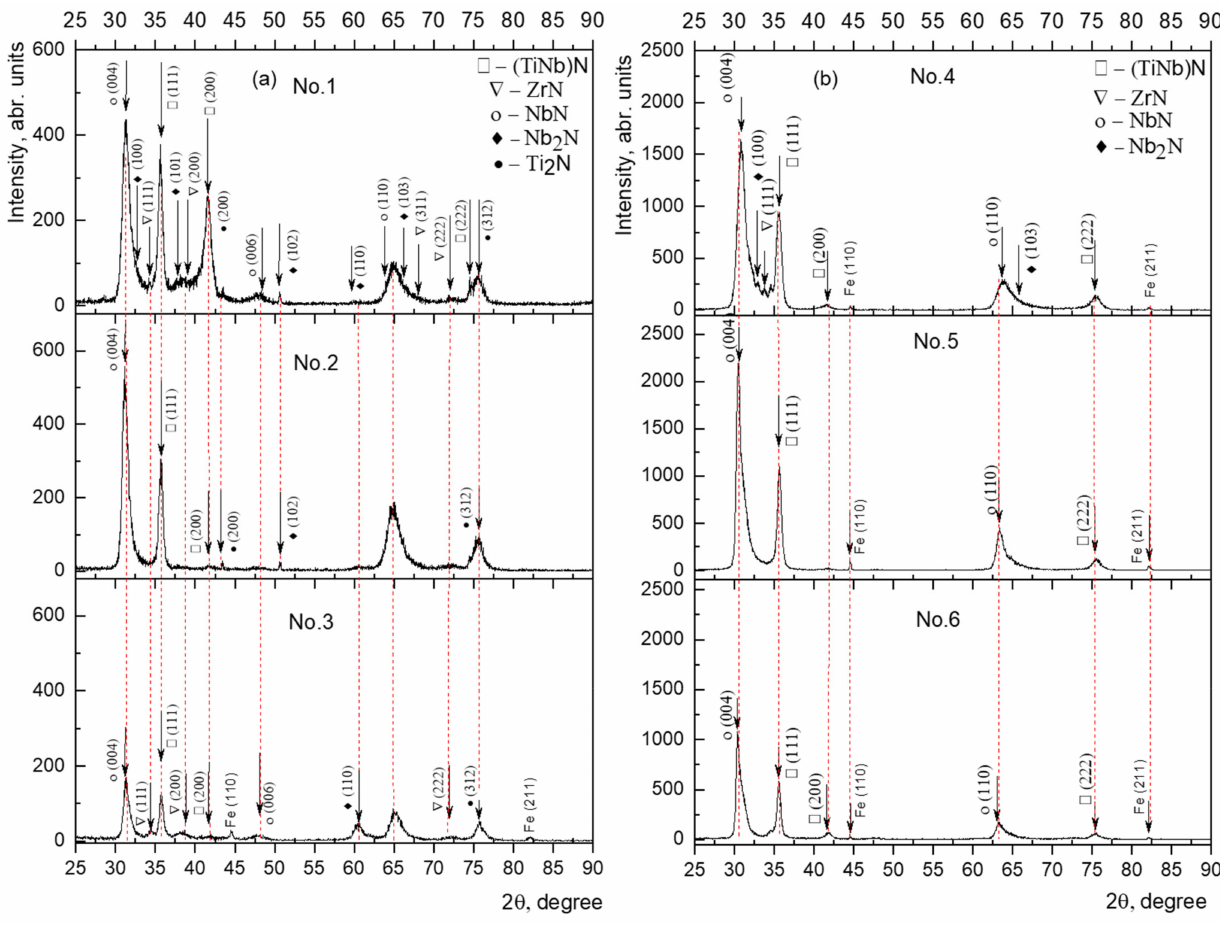
Figure 4. X-ray diffraction pattern of (TiZr/Nb)N coatings at a constant bias potential, U bp , applied to the substrate: ( a ) 200 V, ( b ) 100 V. Table 2. Results of X-ray study of multilayer coatings